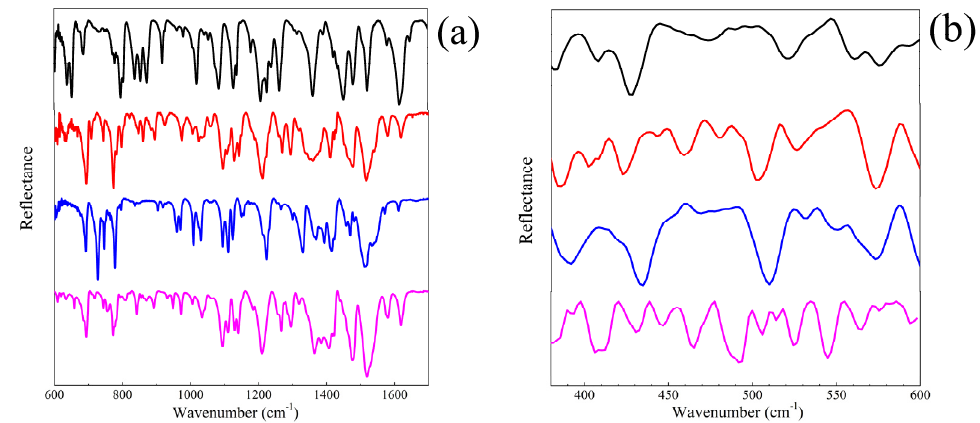
Figure 7. IR spectra of BMIP (black lines) 1 (red lines), 2 (blue lines), and 3 (magenta lines) in ( a ) the 600–1700 cm − 1 , and ( b ) 380–600 cm − 1 spectral ranges.